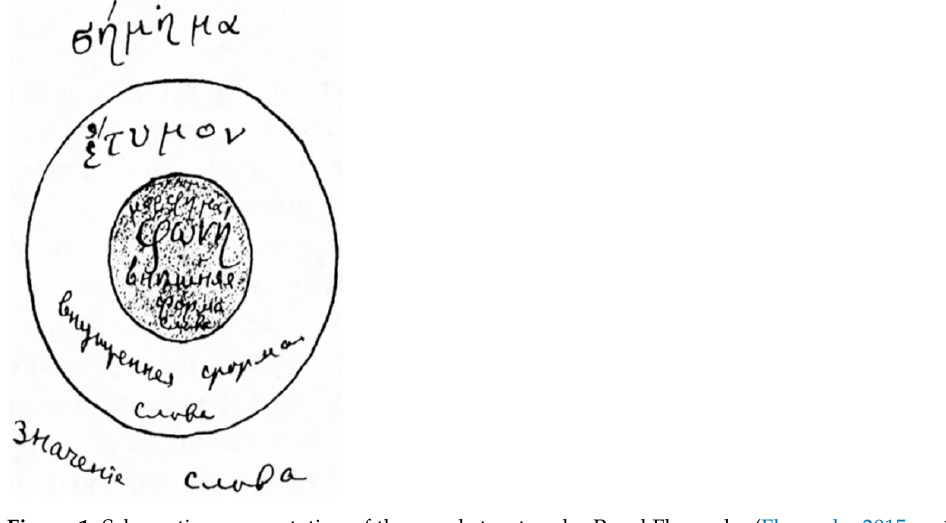
Figure 1. Schematic representation of the word structure by Pavel Florensky (Florensky 2015, p.